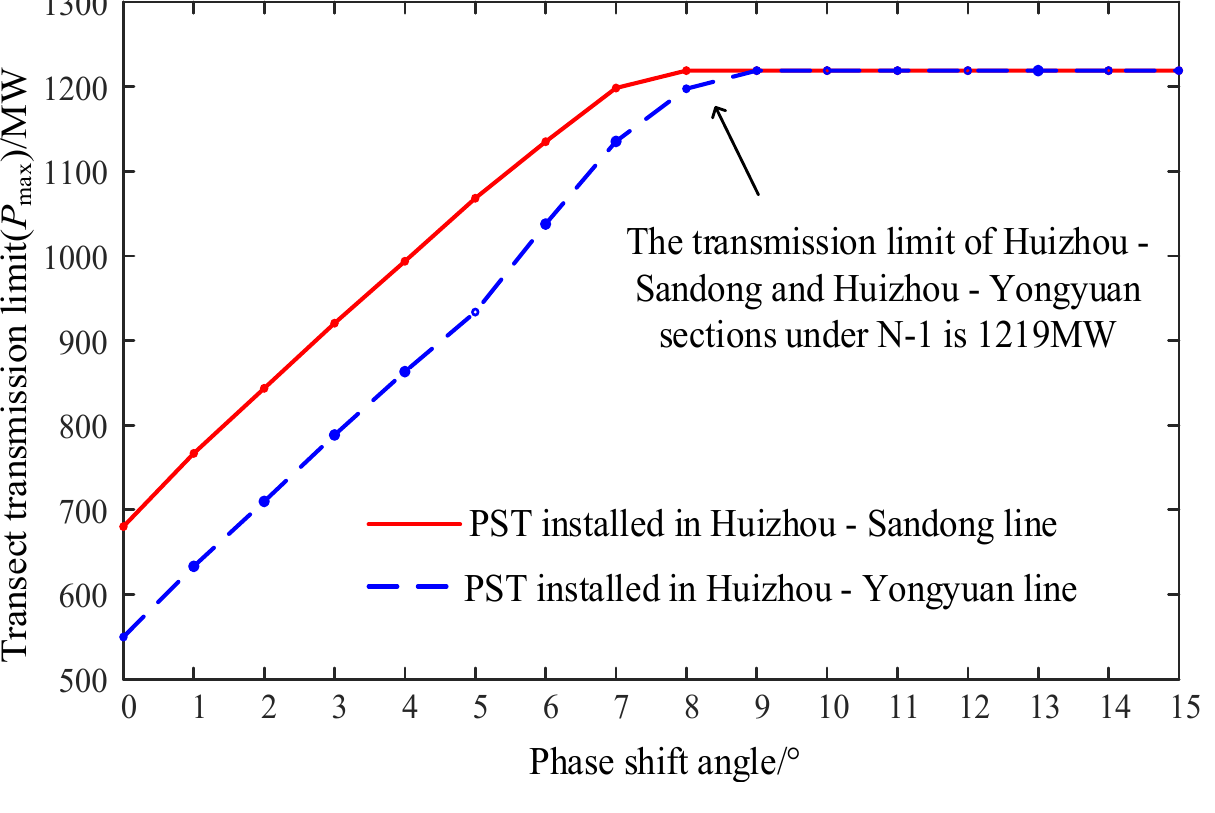
Figure 14. Transmission limit of 220 kV ring network in case of N-1 .